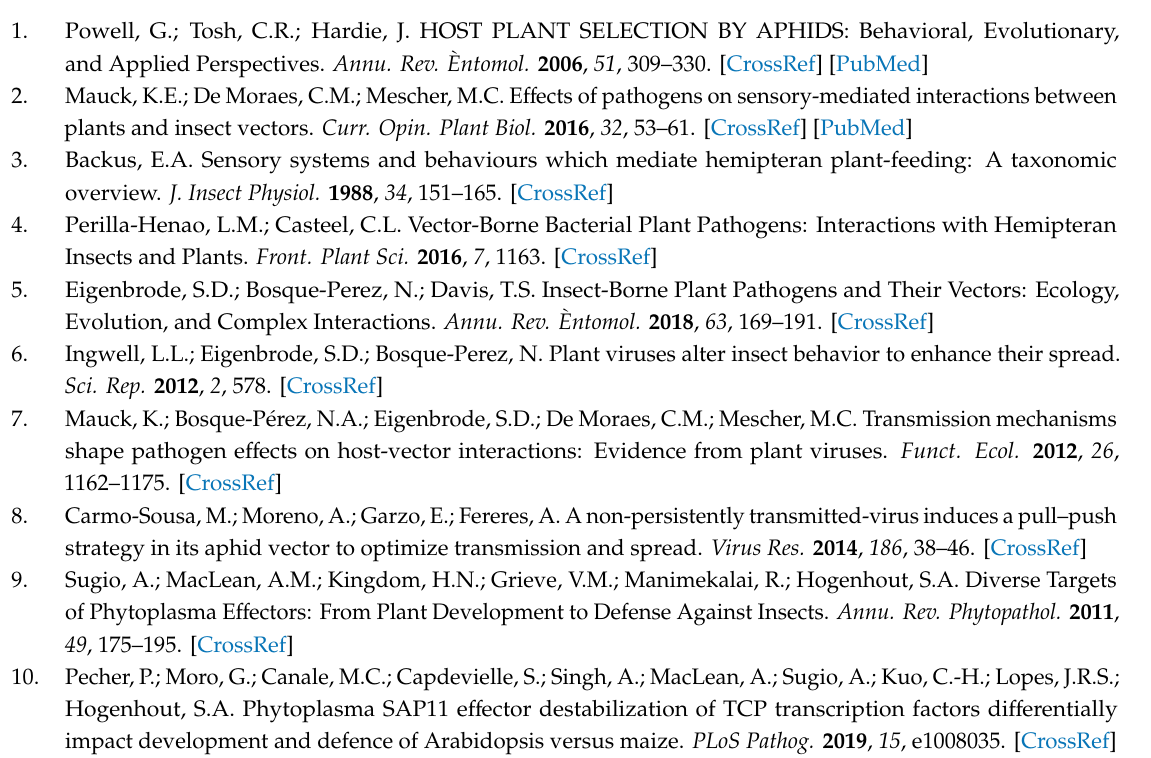
Figure S1: Free-choice arena 30 × 30 × 30 cm. A—Side view. B—Side view with (a) side opening (4 × 20 cm) sealed with “voile” fabric for ventilation. C—Top view with (b) openings (4 × 20 cm) for ventilation and (c) “Falcon” tube from which the insects were released. D—Internal side view showing the openings through which the leaves were inserted (d) 1.5 × 6.0 cm (e) 1.5 × 7.0